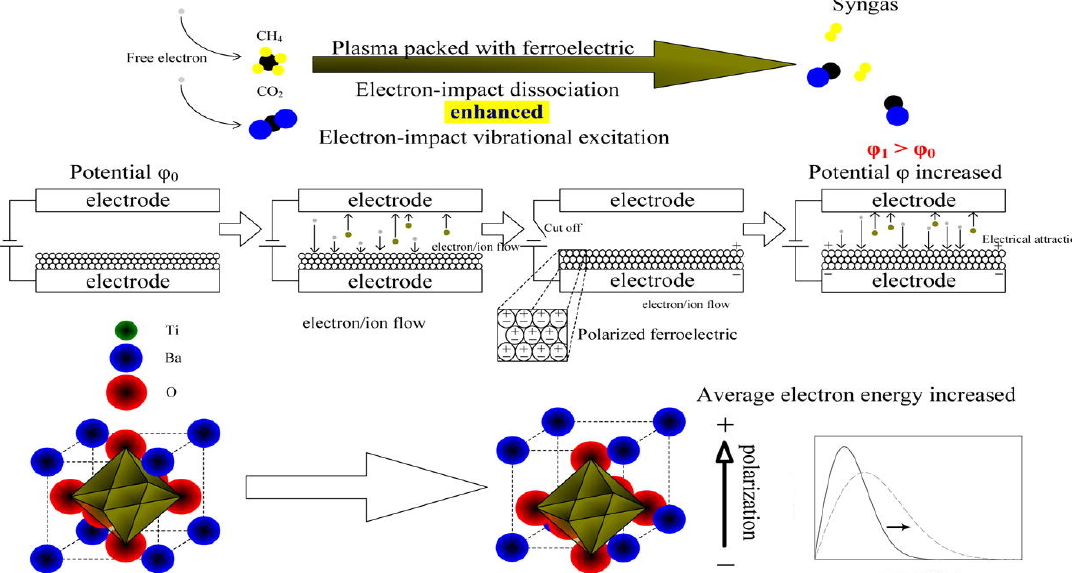
Figure 5. Mechanism of ferroelectric polarization and its effect on reforming. Reproduced with permission from [12]. Copyright 2020, Elsevier.